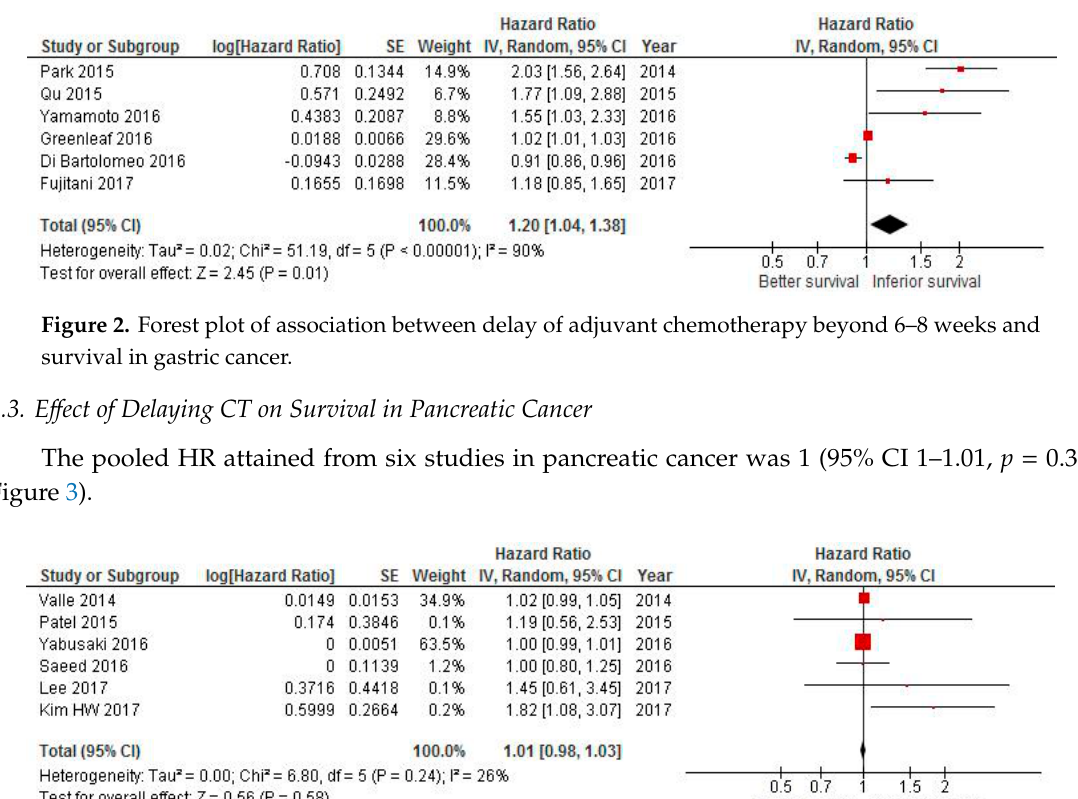
Figure 1. Forest plot of association between delay of adjuvant chemotherapy beyond 6–8 weeks and survival in colorectal cancer. Cancers 2019 , 11 , x FOR PEER REVIEW